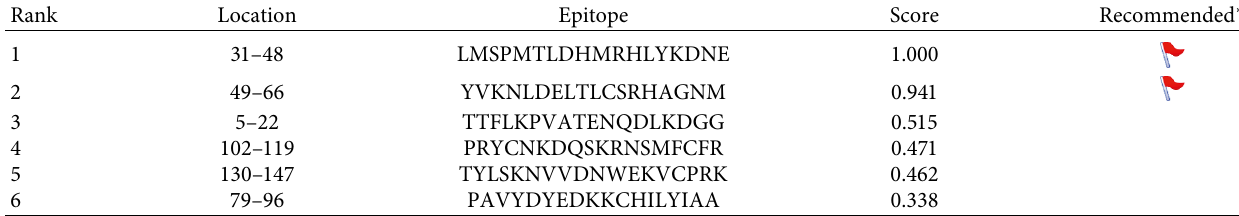
Table 5: Linear B-cell epitope prediction using the SVMTrip tool.